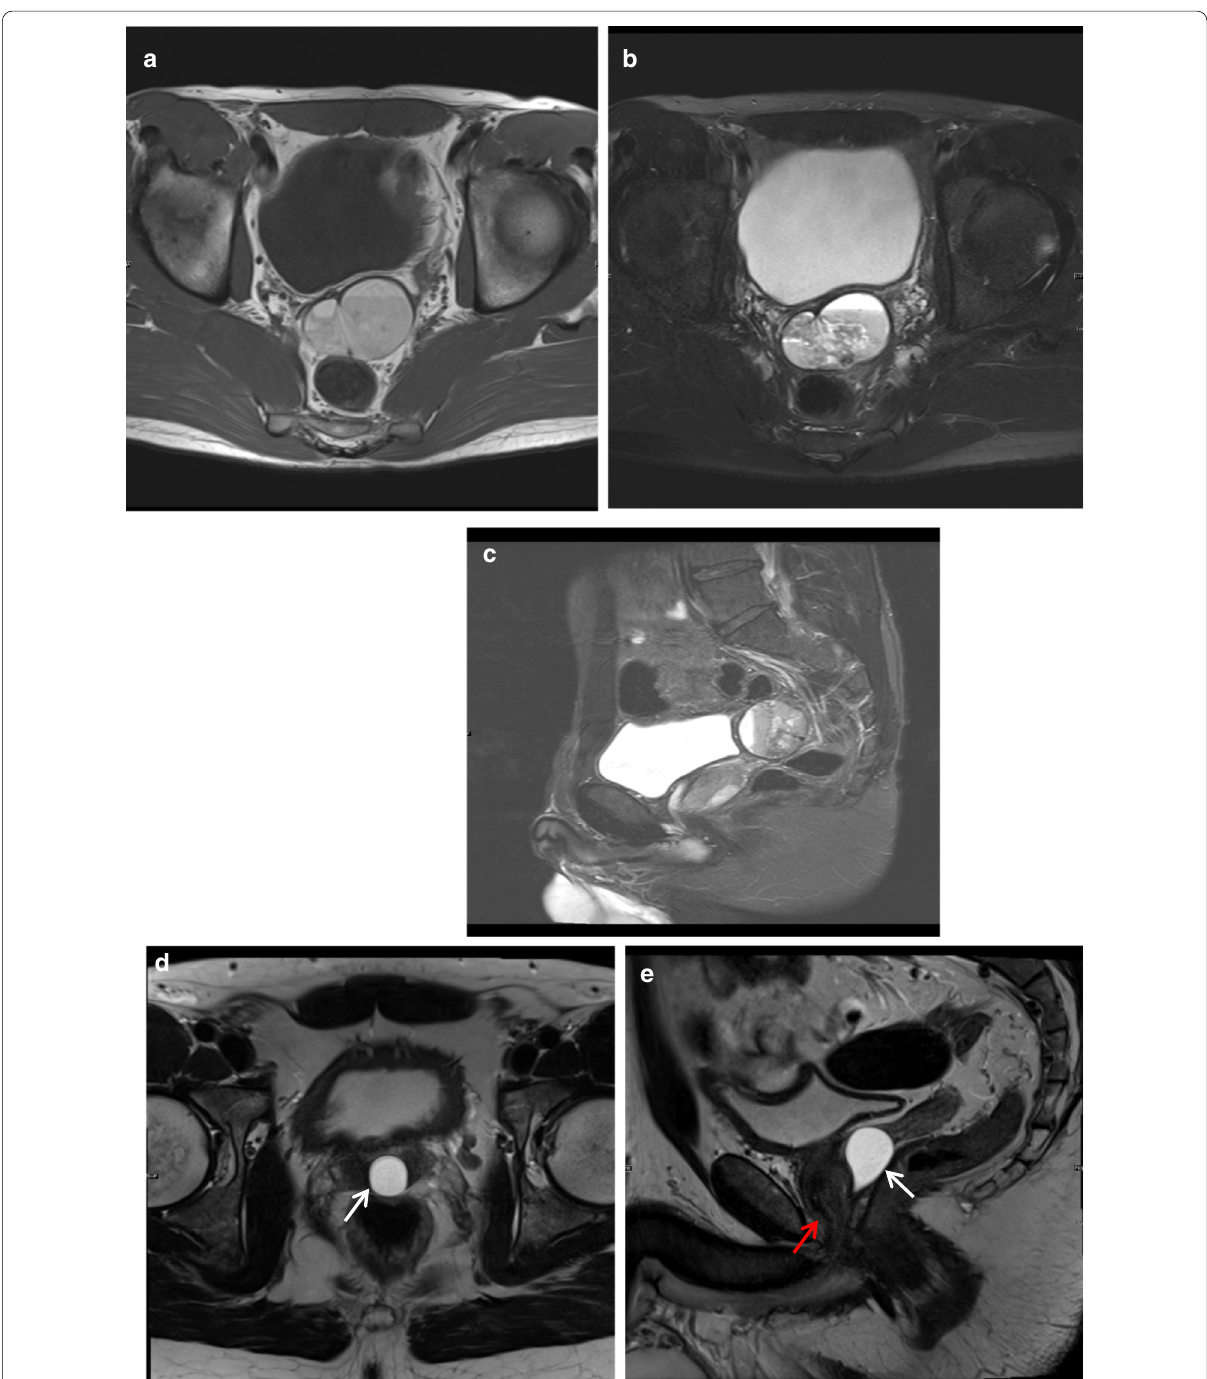
Fig. 4 Mullerian duct cysts Axial a T1W and ( b ) T2W images and Sagittal ( c ) STIR images show a cystic structure with a fluid–fluid level from high signal intensity simple fluid and low signal intensity fluid from haemorrhage. It extends beyond the base of prostate. d Axial and ( e ) sagittal T2W images show another case with a midline cystic structure (white arrows) with homogeneous high T2 signal which is bulbous at the superior aspect with an inverted droplet morphology inferiorly. The base of the lesion does extend above the level of the base of the prostate gland which is shown by the red arrow. These are in keeping with Mullerian duct